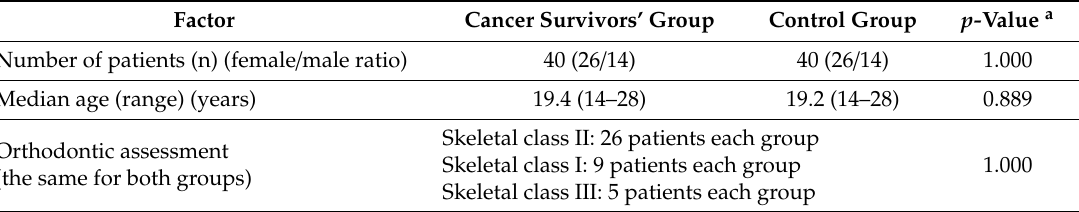
Figure 1. The flow chart of participation diagram. Table 1. Baseline characteristics of cancer survivors’ and control group of patients.